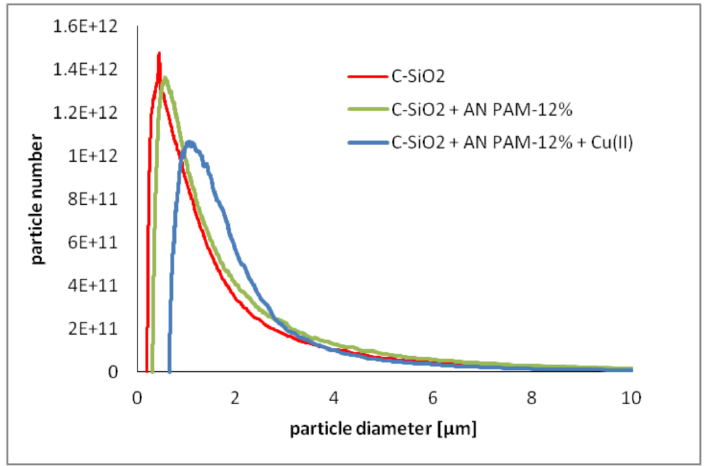
Figure 6. Turbidity changes of the C-SiO 2 suspension without and with ionic polyacrylamide and/or Cu(II) ions over time at pH 6; the PAM concentration was 50 ppm ( a , b ) or 100 ppm ( c , d ), whereas the Cu(II) one—100 ppm.